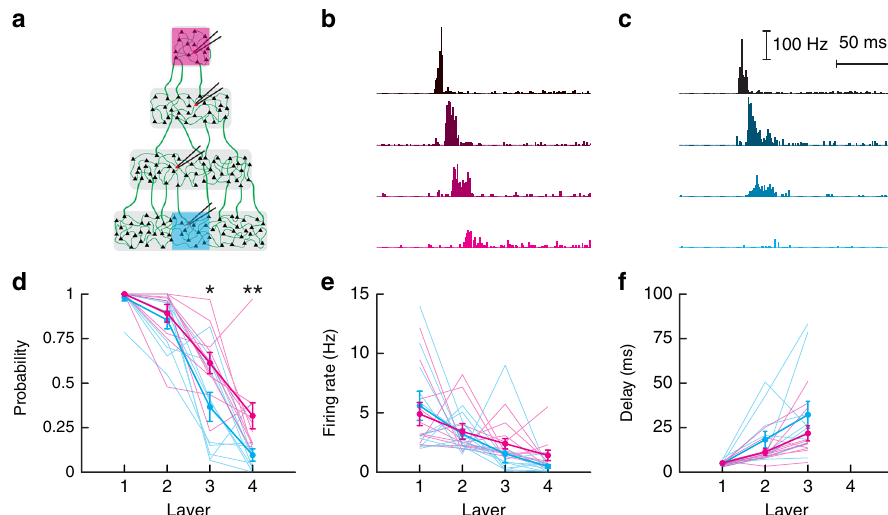
Fig. 9 Propagation in networks of different sizes. a Schematic of the multilayer network with compartments of different sizes. All layers were 0.5 mm in width with lengths of 0.5, 1, 1.5, and 2 mm from top to bottom. An area of same dimension was photostimulated either in the smallest (magenta) or in the largest (cyan) compartment. b , c Average poststimulus time histogram of neurons when the small ( b ) or the large ( c ) network was stimulated. In each network, a single neuron is recorded in each layer (from black to magenta (cyan) for layers 1 – 4, respectively). Data were averaged from n = 11 networks of density = 297 ± 111 neurons·mm − 2 (mean ± STD). d – f Spike probability ( d ), fi ring rate ( e ), and delay of fi rst spike ( f ) as a function of layer when the smallest (magenta) or the largest (blue) network was activated. In d – f all data are shown and the mean ± SEM is represented as thick lines. Paired Mann – Whitney U -test statistics: d L1: P = 1, L2: P = 0.643, L3: P = 0.024, L4: P = 0.019; e L1: P = 0.898, L2: P = 0.898, L3: P = 0.102, L4: P = 0.067; f L1: P